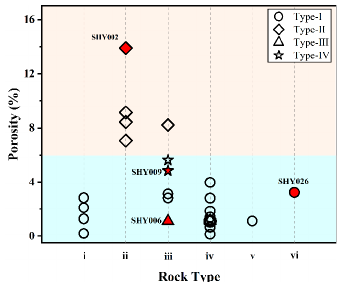
Figure 9. Porosity plotted against rock type. Marker color represents pore type.